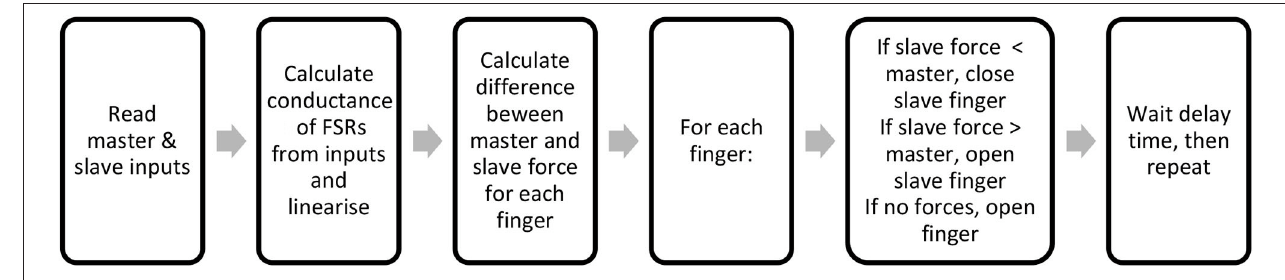
FIGURE 5 | Control loop